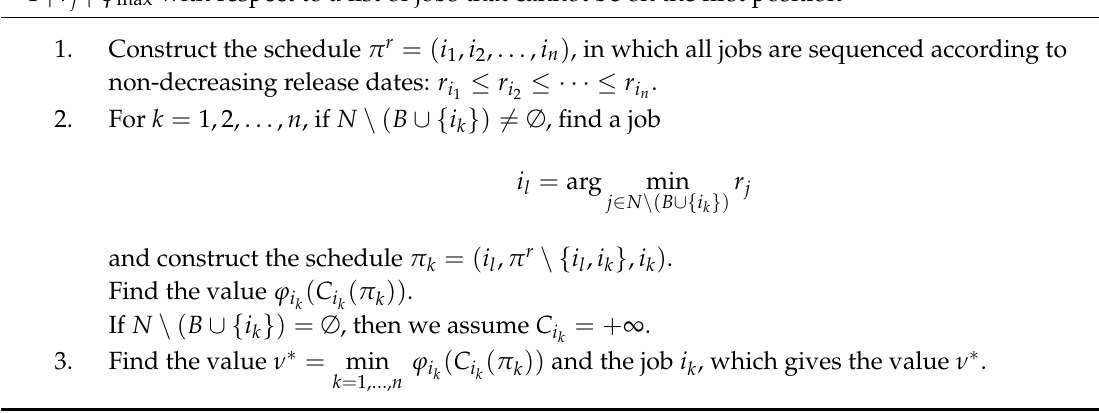
Algorithm 3: Modification of the solution algorithm for the dual problem of the